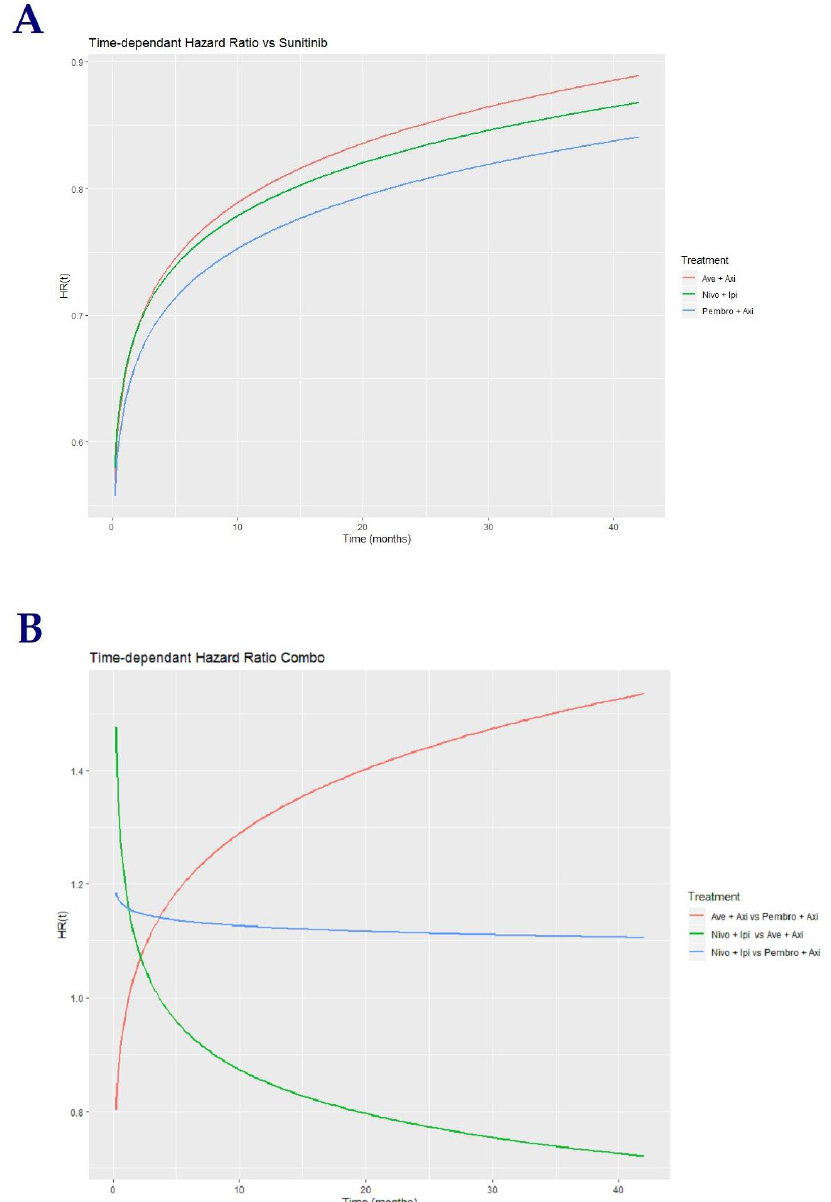
Figure 5. Time-dependent HRs for OS of combinations. ( A ) Time-dependent hazard ratio vs. sunitinib. Red: Ave-Axi vs. sunitinib, Green: Ipi-Nivo vs. sunitinib, Blue: Pembro-Axi vs. sunitinib. ( B ) Time-dependent hazard ratio between combinations. Red: Ave-Axi vs. Pembro-Axi, Green: Ipi-Nivo vs. Ave-Axi, Blue: Ipi-Nivo vs. Pembro-Axi.